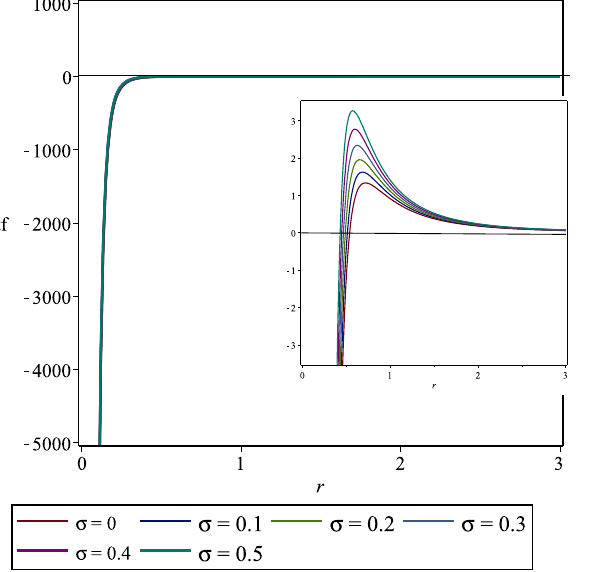
Fig. 4 Angular tidal force for a Kiselev BH surrounded by dust for chosen values of the dust parameter, also we have q = 0 . 6 and b = 100